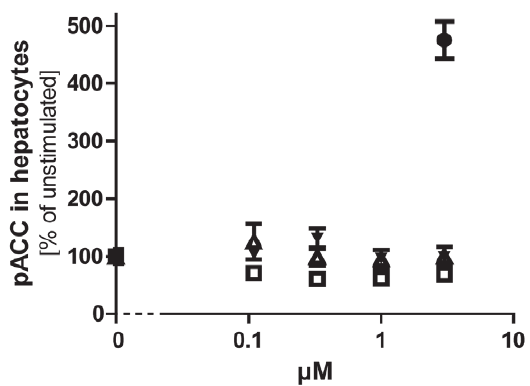
Figure 2. Stimulation of ACC phosphorylation in hepatocytes. Purified trimeric hAd (open squares), hexameric hAd (closed triangles), HMW hAd (open triangles) and 1 mM AICAR (closed circle, located at 3 m M) was used to stimulate ACC phosphorylation (pACC) in primary rat